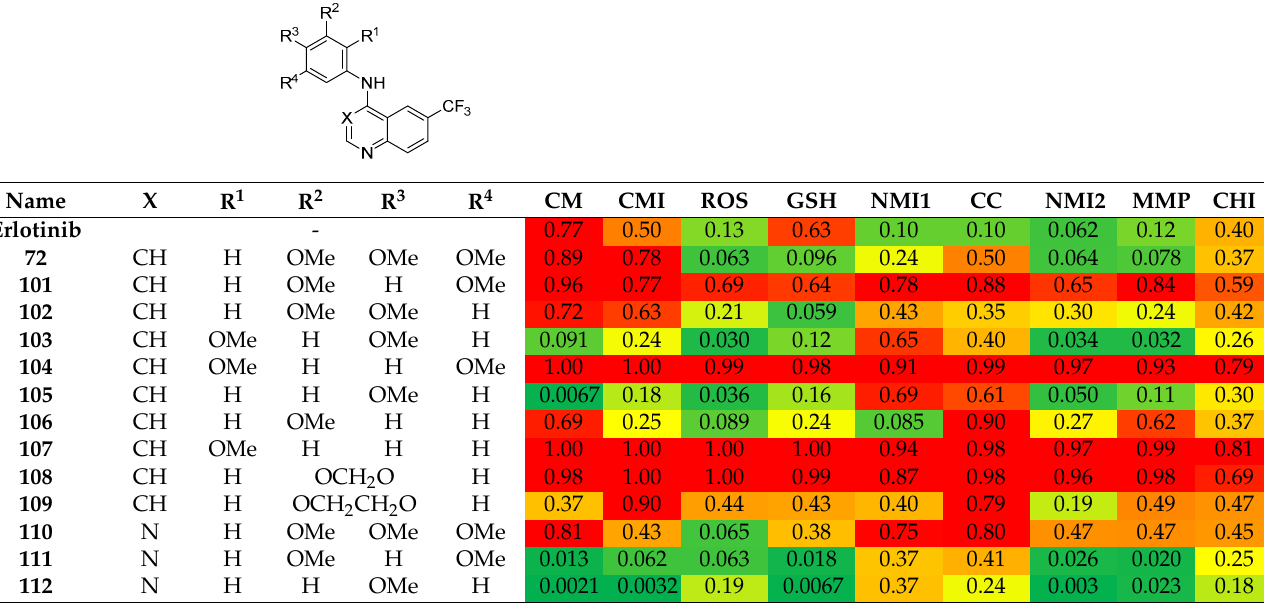
Table 8. Toxicity profiling of different oxygen substituted anilines based on the scaffold of analog 72 ( 101 – 112 ) a,b,c .